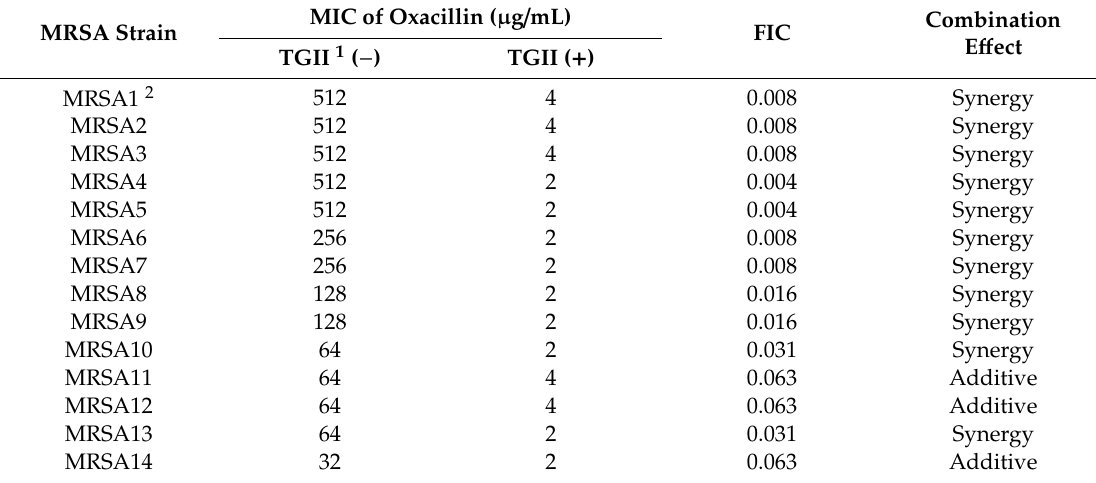
Table 2. MIC and fractional inhibitory concentration (FIC) of oxacillin with or without TGII against clinically isolated MRSA strains.